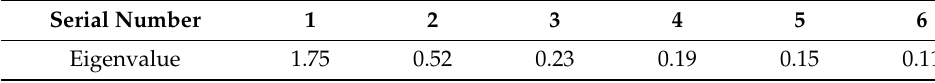
Table 8. Six largest eigenvalues.